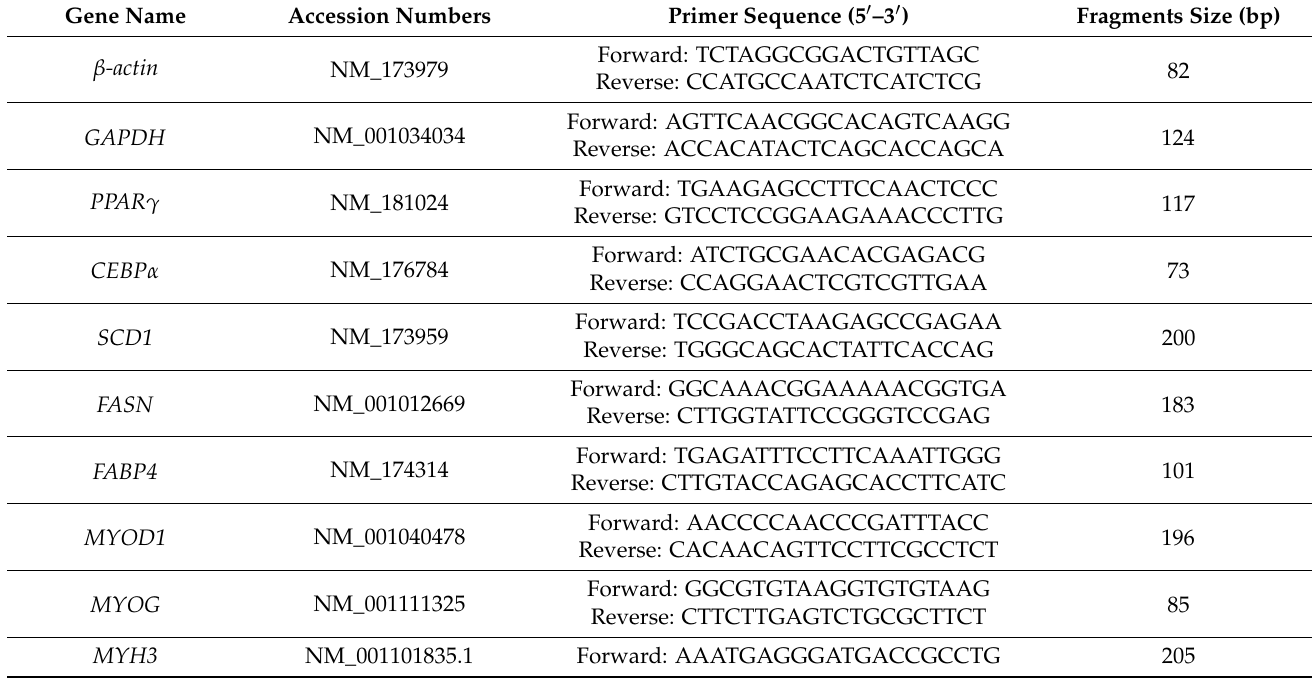
Table 1. Sequence information of the primers of qRT-PCR related genes in this